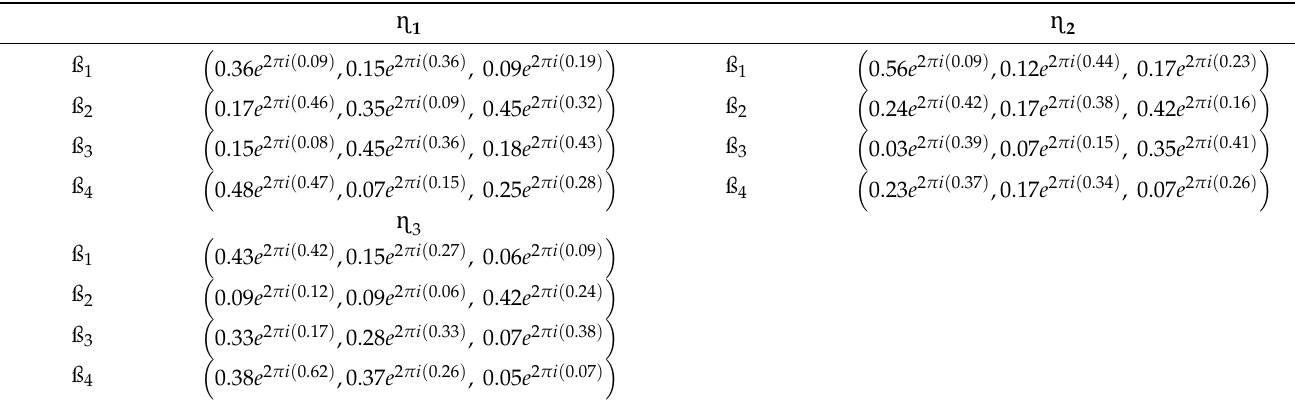
Table 3 for the parametric value of ɰ = 2 . Table 2. The decision matrix in the form of CPFVs. Table 2. The decision matrix in the form of CPFVs. Table 2. The decision matrix in the form of CPFVs. Table 2. The decision matrix in the form of CPFVs. Table 2. The decision matrix in the form of CPFVs. Table 2. The decision matrix in the form of CPFVs. Table 2. The decision matrix in the form of CPFVs.